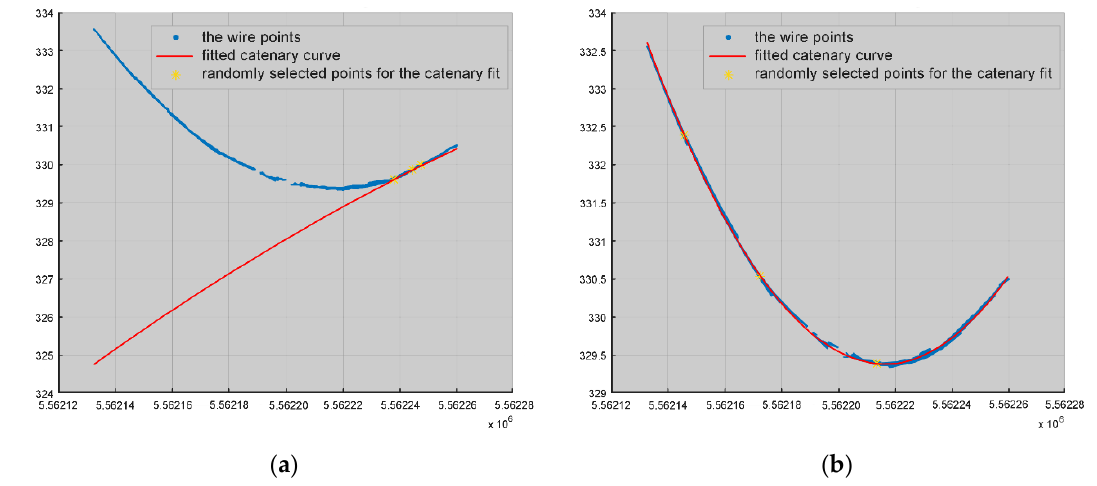
Figure 12. The catenary curve fitting based on the randomly selected points: ( a ) without control, ( b ) with the implementation of the RANSAC algorithm.